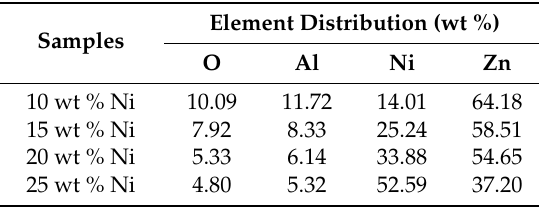
Table 2. EDS analysis of LPCS Zn-Ni composite